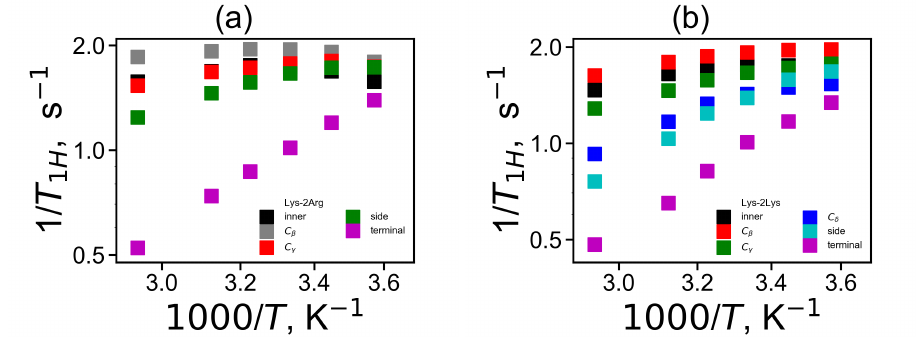
Figure 13. The 1 H NMR spin-lattice relaxation rate 1/ T 1 H as a function of inverse temperature 1000/